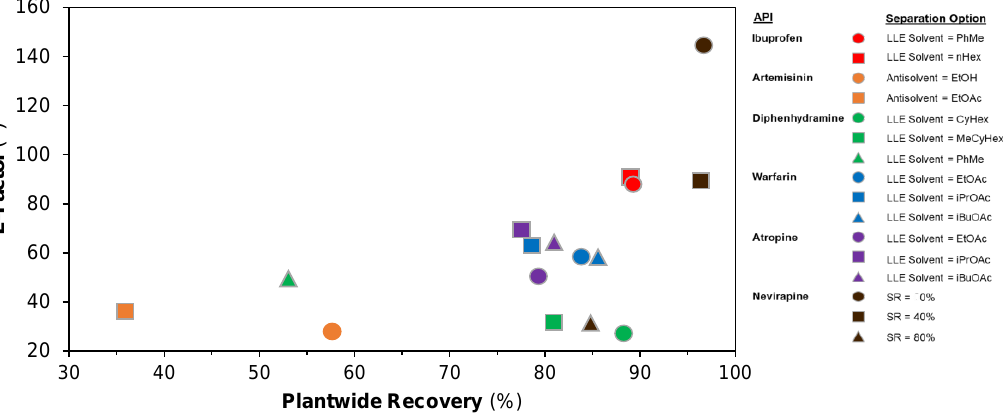
Figure 19. Plantwide E-factors vs. attained API recoveries for different design cases.